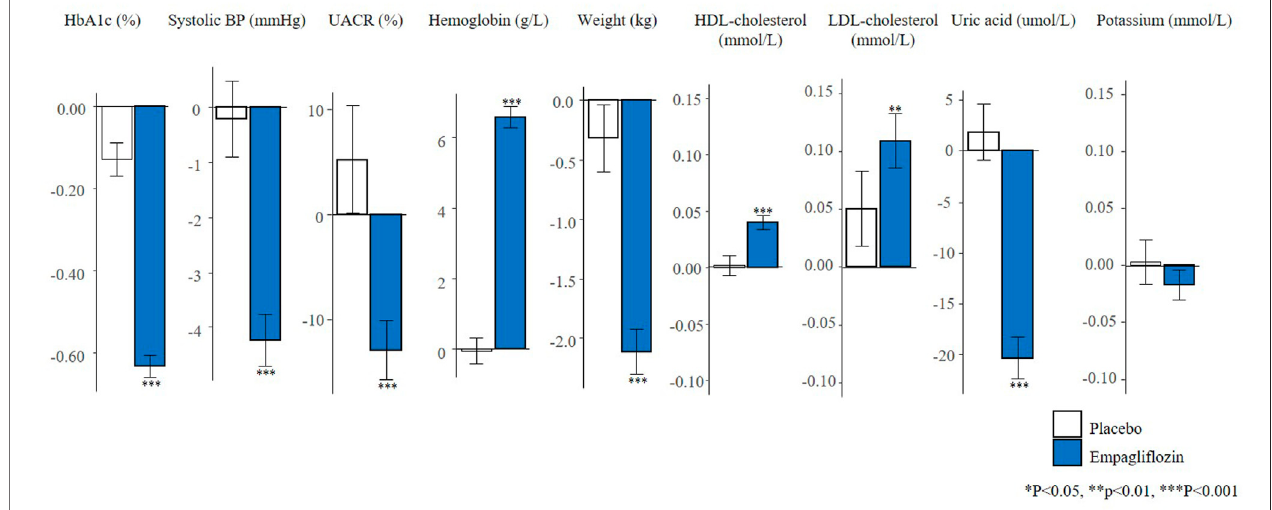
FIGURE1| Meanchangesinriskmarkersfrombaselineto6-monthsinthe totalpopulation oftheEMPA-REG OUTCOME trial (N (cid:1) 7020). Changesarepresented as mean with 95% con fi dence interval, for the placebo and empagli fl ozin group. HbA1c, glycated hemoglobin; BP, blood pressure; UACR, urinary-albumin-creatinine- ratio; HDL, high-density-lipoprotein; LDL, low-density-lipoprotein.